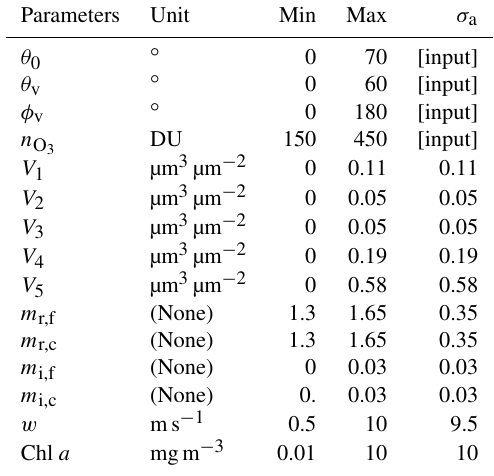
Table 1. Parameters used to train the FastMAPOL forward model as described in Sect. 2.2. The minimum (min) and maximum (max) values of each parameter are also shown. The a priori uncertainties ( σ a ) are estimated as the difference between the max and min values for the study in Sect. 3, except the four parameters as indicated, which are assumed as known